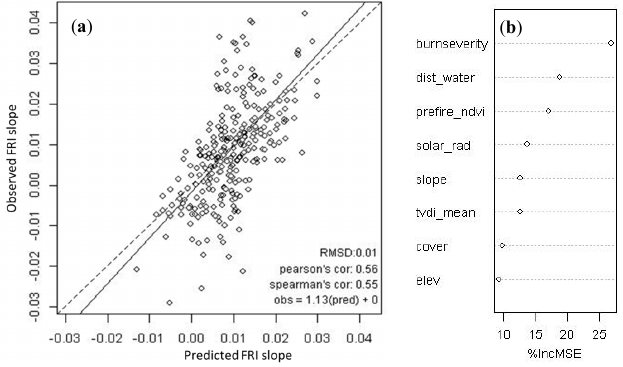
Figure 10. Observed and predicted FRI based forest recovery rate using the random forest algorithm ( a ) and the importance of predictors in classifying forest recovery rates ( b ). The importance of predictions measures the increase of mean square error (MSE) in the classification of a response variable if one of these predictors is excluded from the